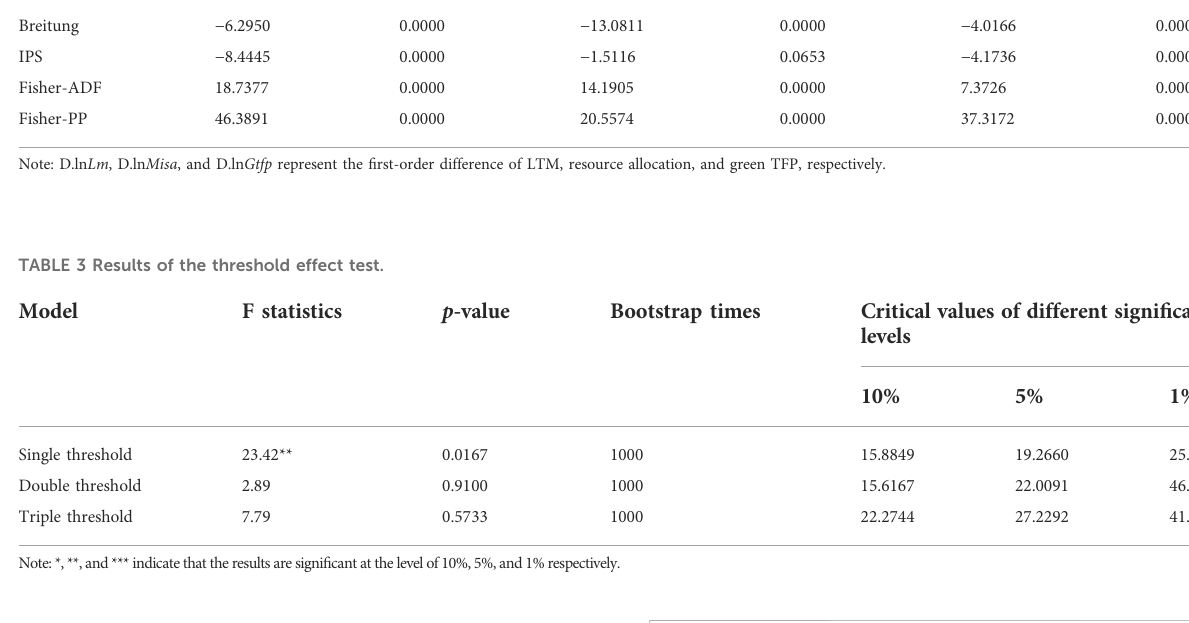
TABLE 4 Single threshold estimation results.